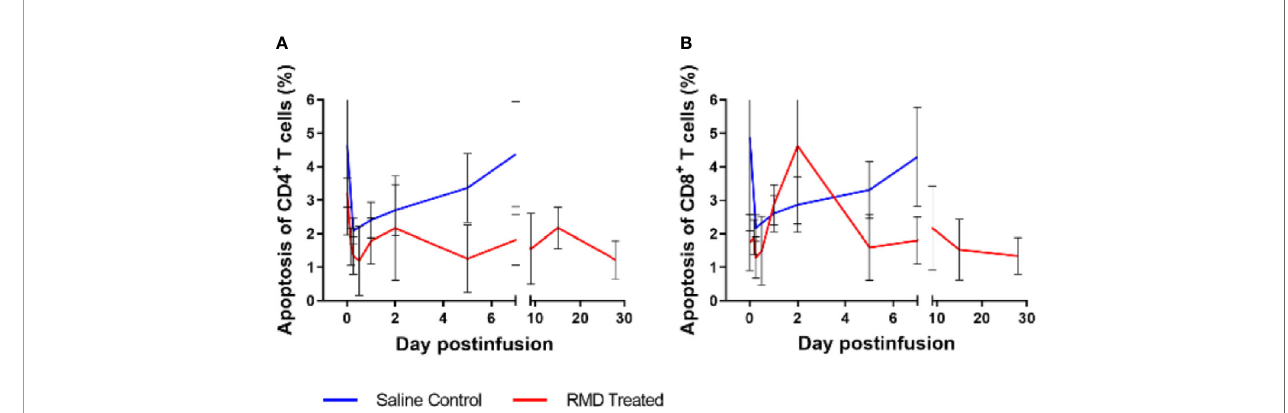
FIGURE 6 | Peripheral blood lymphocyte apoptosis with RMD treatment. Whole blood was stained with Annexin V and Live/Dead stain to determine apoptosis of CD4 + (A) and CD8 + (B) T cells; animal number, n = 3 per group.